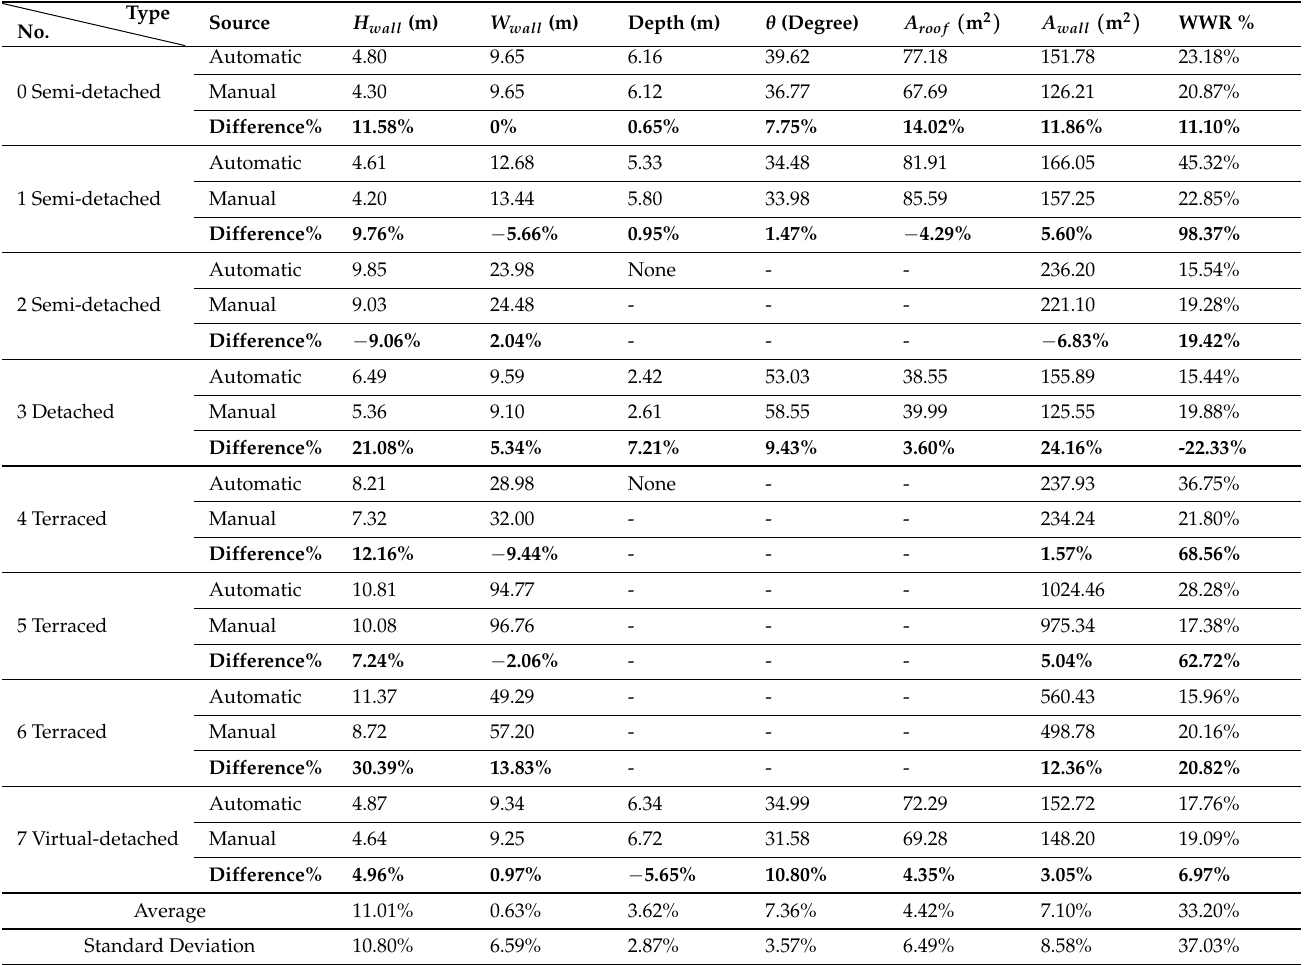
Table 2. Quantitative evaluation of the developed automatic building measurement algorithm. H wall represents the total building height; θ represents the roof pitch angle; A roof and A wall are the total roof and the wall area, respectively; and WWR is the window-to-wall